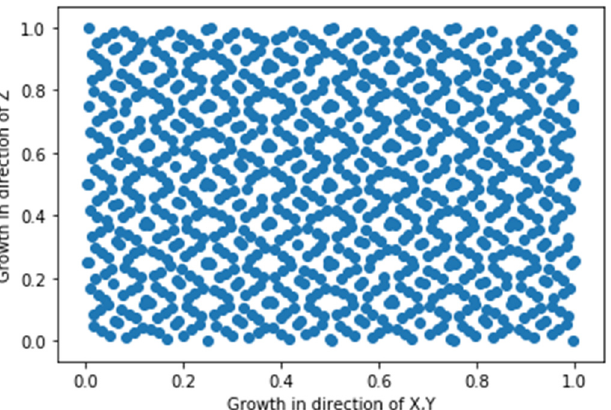
Figure 5. The 1000 feasible DoE points generated by the Sobol sequence shown on a 2D subspace of the 3D design space.